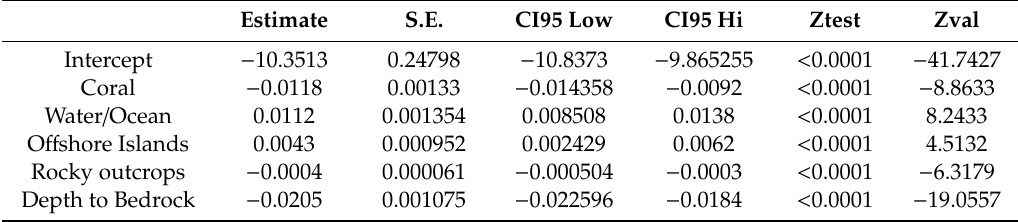
Figure 8. Results of the residual K- and G-function tests on PPM1 (the Davis et al. [49] model) and best fitted models PPM3 and PPM4. Both PPM3 and PPM4 perform better than the Davis et al. algorithm but still overestimate clustering between points at some distances. Table 3. Results of the chosen best fitting model (PPM3), including the parameter estimates and standard errors with a 95% confidence interval for each covariate. S.E. = standard error. CI95 = 95% confidence